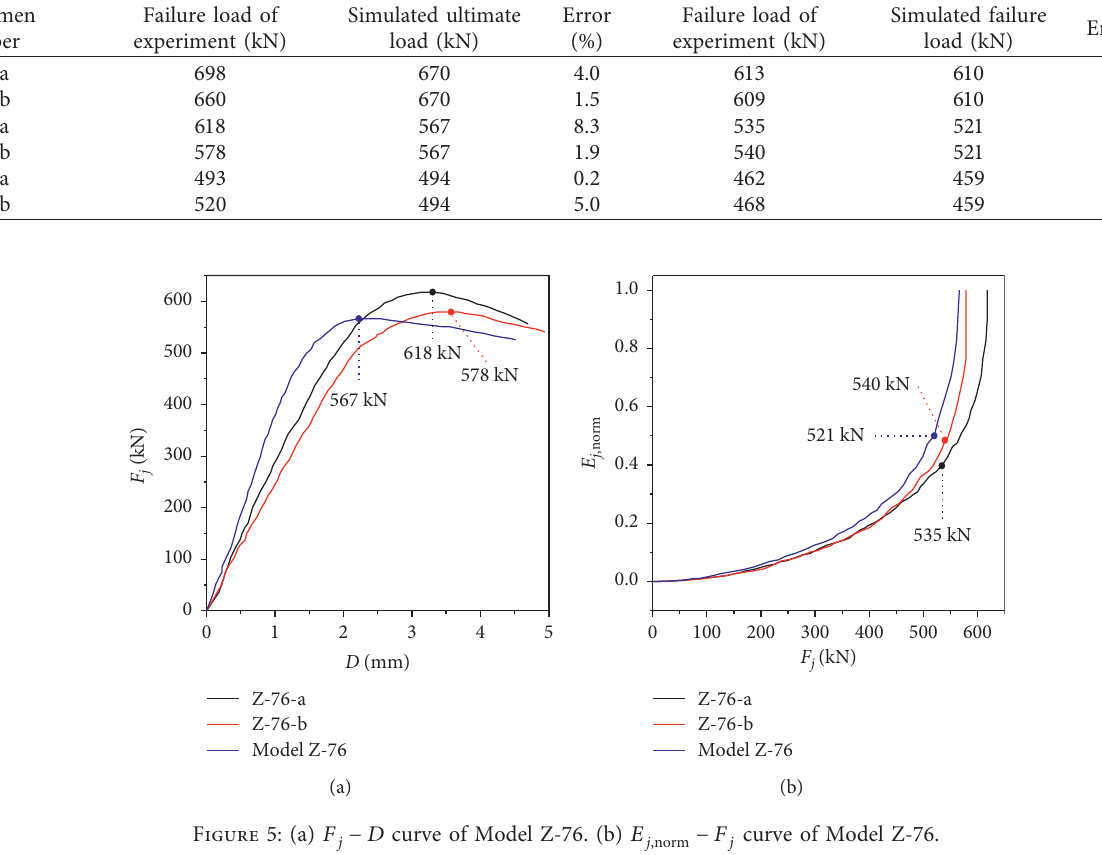
− D curve of Model Z-76. (b) E j